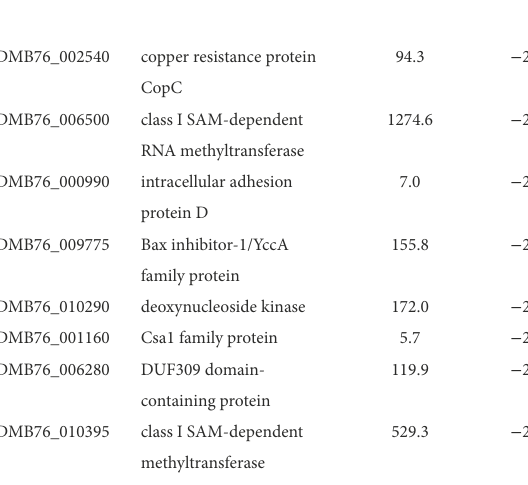
TABLE 2 List of differentially expressed genes of S. saccharolyticus 13 T0028 grown in biofilm compared to planktonic cells at 48 h with a log2-fold change of >2 or < −